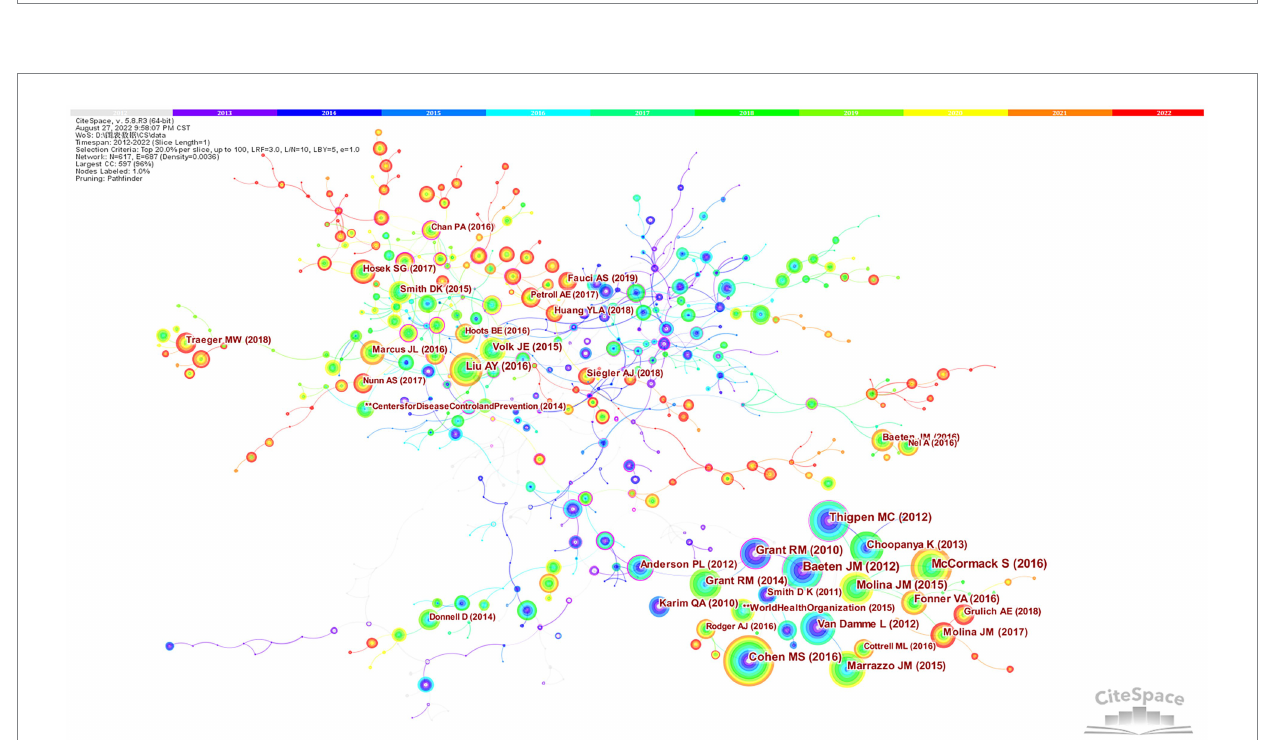
FIGURE 5 Reference cocitation